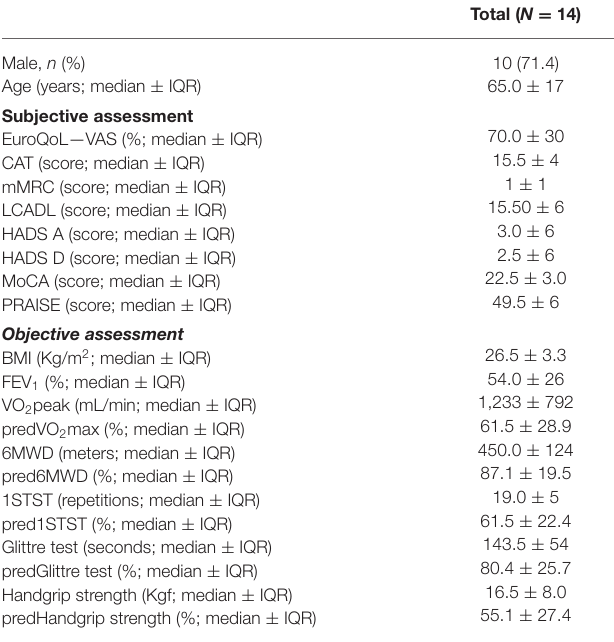
TABLE 2 | Baseline patient